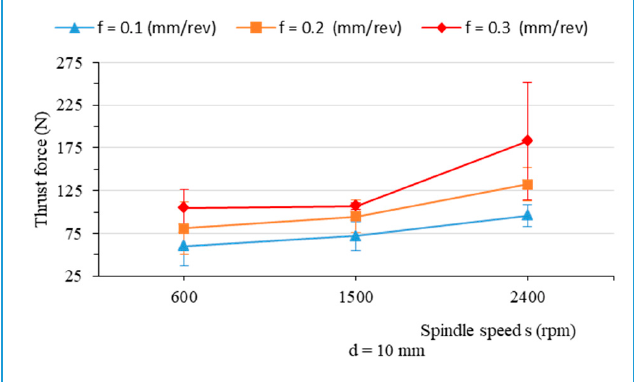
Figure 5. Thrust force versus the spindle speed when drilling hybrid biocomposite using drill bit diameter of 10 mm with various feed rates .